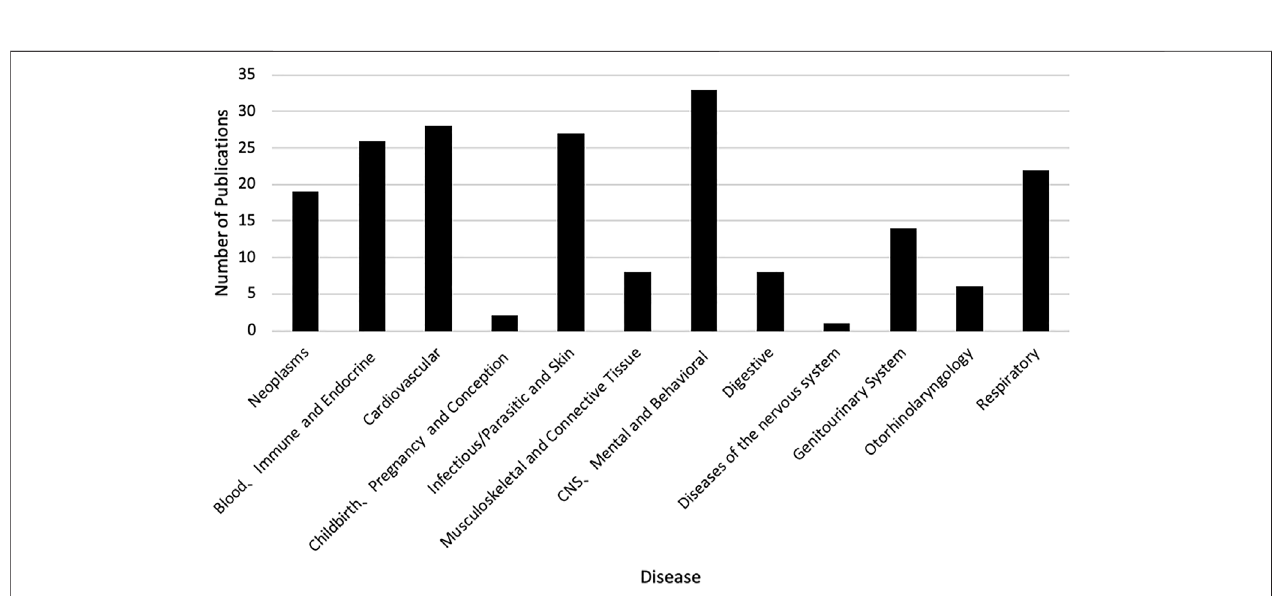
FIGURE 3 | The number of publications of pharmacoeconomics evaluation of herbal medicine by diseases. CNS, Central nervous system.